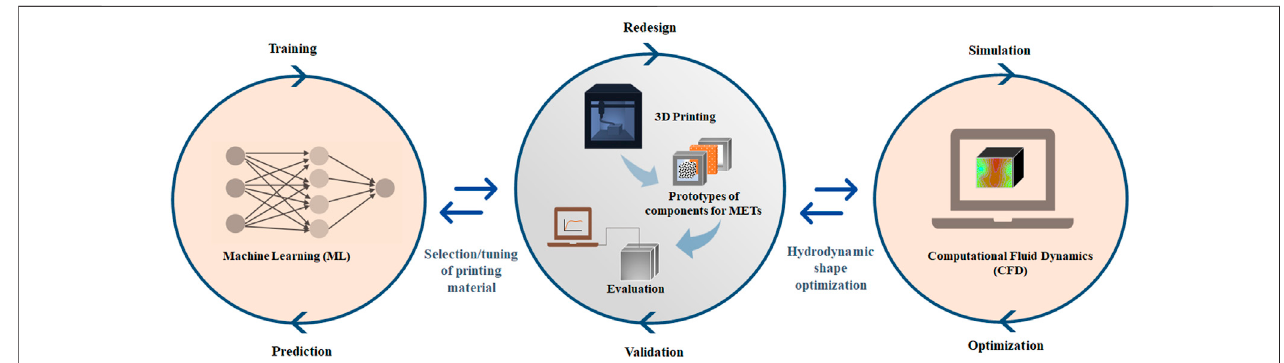
FIGURE 1 | A proposed framework combining 3D printing with machine learning (ML) and computational fl uid dynamics (CFD) modeling for design, optimization, and fabrication of systems for METs.